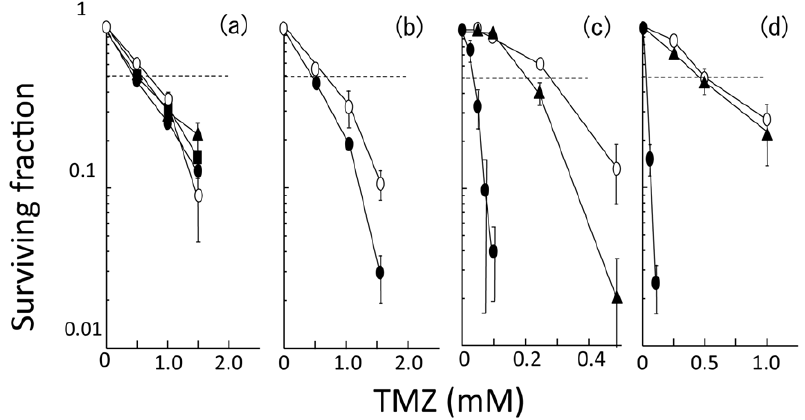
Figure 2. Sensitivity to TMZ. a , FANCwt cells (open circles), FANCA 2 / 2 C 2 / 2 cells (closed triangles), FANCC 2 / 2 cells (closed squares), and FANCA 2 / 2 cells (closed circles); b , FANCwt cells (open circles) and FANCD2 2 / 2 cells (closed circles); c , FANCGwt cells (open circles), FANCGrev cells (closed triangles), and FANCG 2 / 2 cells (closed circles); d , FANCD1wt cells (open circles), FANCD1rev cells (closed triangles), and FANCD1mt cells (closed circles). Each point represents the mean of three independent experiments; bars indicate the